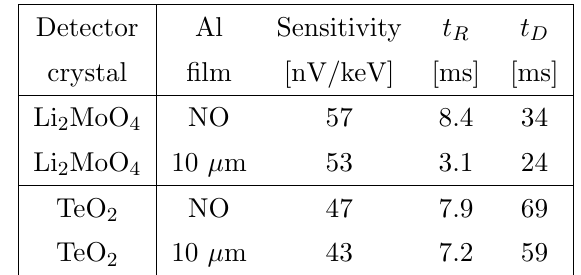
Figure 3 . Left panel: (cid:13) spectrum collected with a bare-crystal TeO 2 bolometer. Peaks generated by the environmental radioactivity and by a 232 Th calibration source are appreciable. Right panel: (cid:13) spectrum collected in similar environmental conditions with an identical TeO 2 bolometer but with one 20 (cid:2) 20 mm crystal side coated by a 1 (cid:22) m thick Al (cid:12)lm. In the insets, the 609 keV (cid:13) peaks of 214 Bi are shown to compare the energy resolutions.